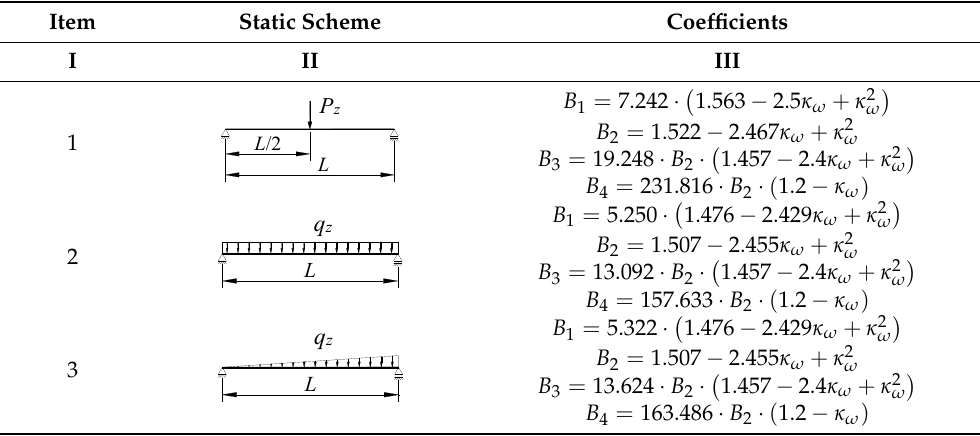
Table 3. Coefficients B 1 , B 2 , B 3 , B 4 for simply supported beams ( M cr,o ) and selected loading schemes. Item